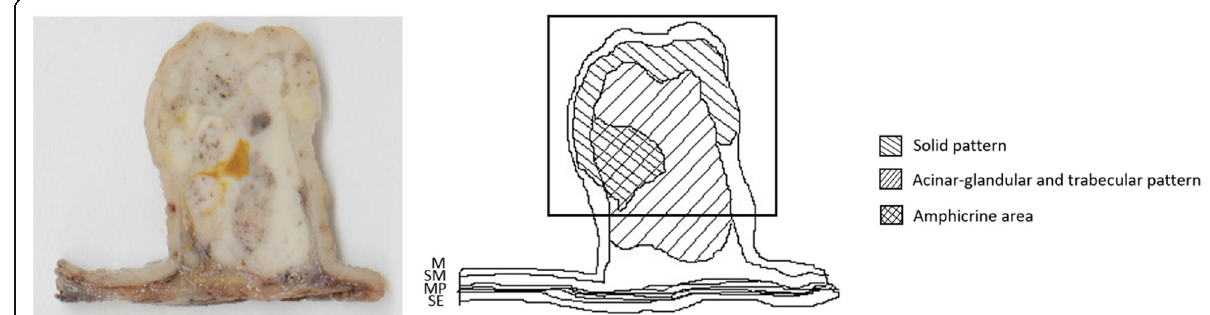
Fig. 4 Schematic diagram of each component. The square indicates the area shown in Fig.